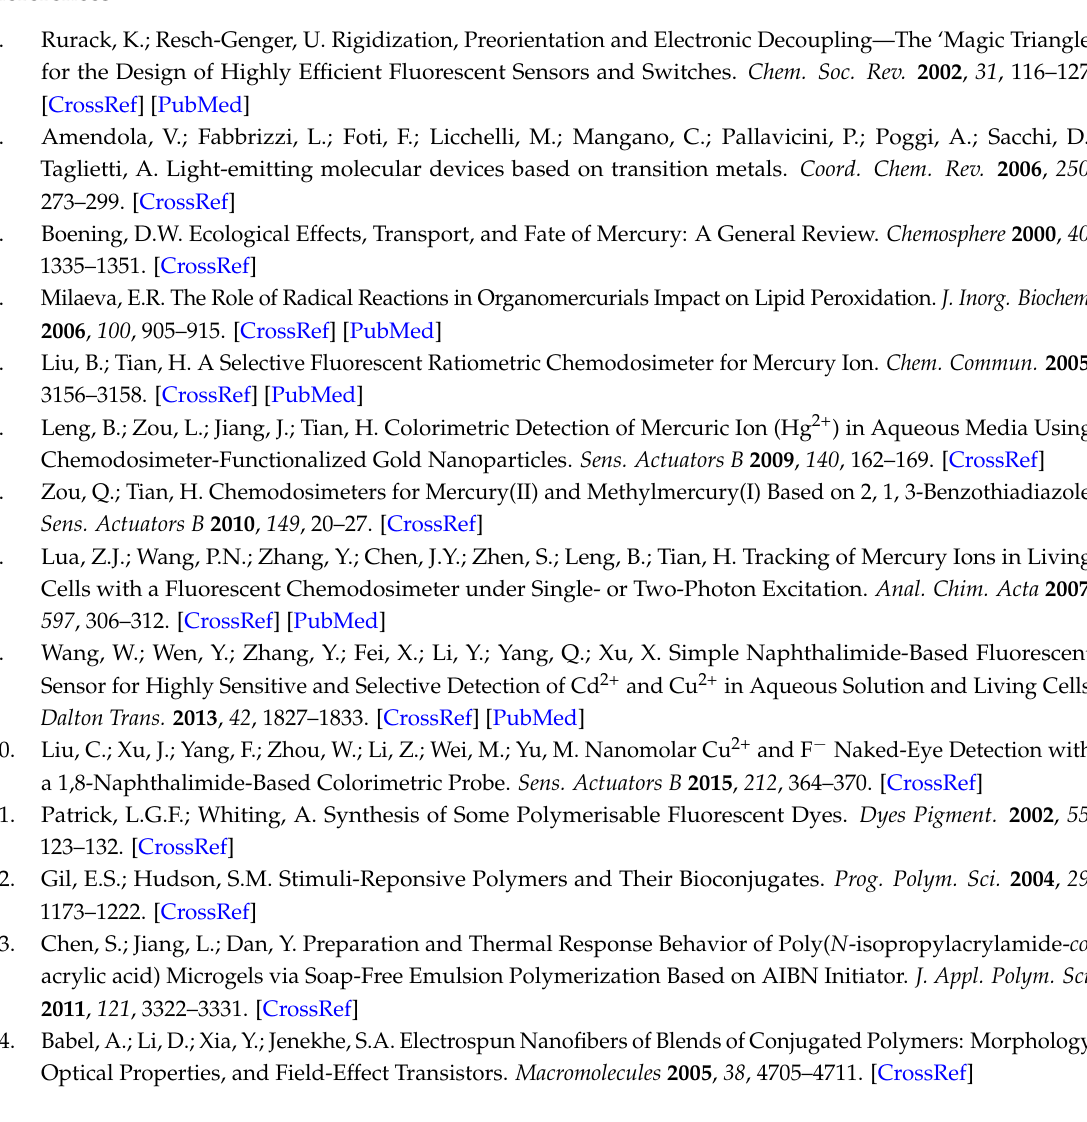
Figure S1: GPC profiles of P1 and P2 copolymers. Figure S2: TGA curves of P1 and P2 copolymers with a heating rate of 10 ◦ C min − 1 in a nitrogen atmosphere. Figure S3: Variations in optical transmittance of P1 and P2 in pH 7 water solutions with temperatures between 30 and 60 ◦ C. Figure S4: TGA curves of P2-5% blended with 5 wt % Fe 3 O 4 NPs nanofibers with a heating rate of 10 ◦ C min − 1 in a nitrogen atmosphere. Figure S5: PL intensity of pristine BNPTU compound as the temperature is increased from 30 to 60 ◦ C. Table S1: Time-dependent solution conductivity of the prepared Hg 2+